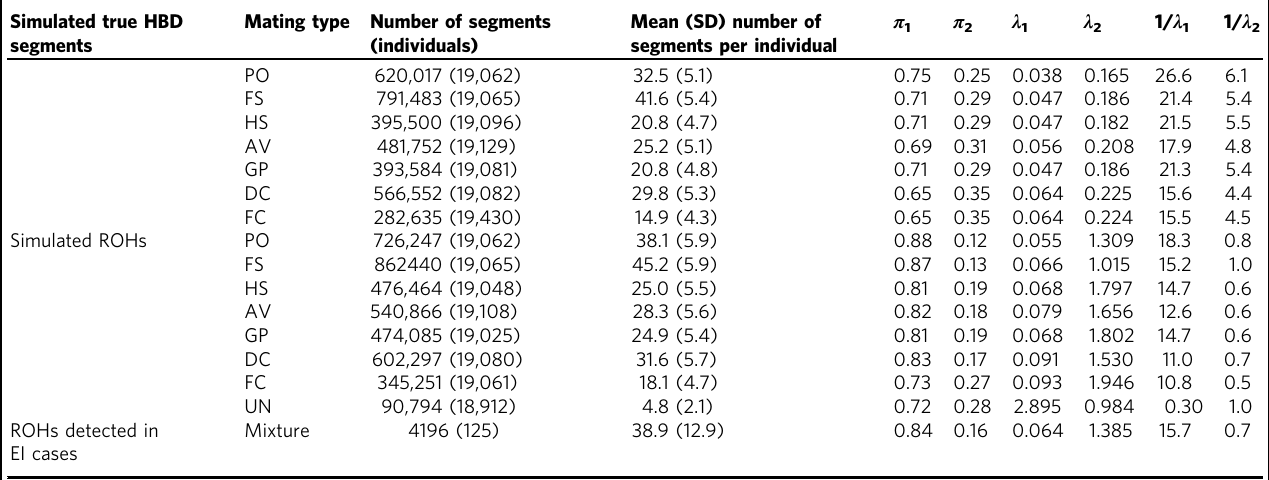
Table 2 Parameters of mixtures of exponential distributions estimated from observed length distributions of homozygous-by- descent (HBD) genomic segments and runs of homozygosity (ROH) Simulated true HBD Mating type Number of segments segments